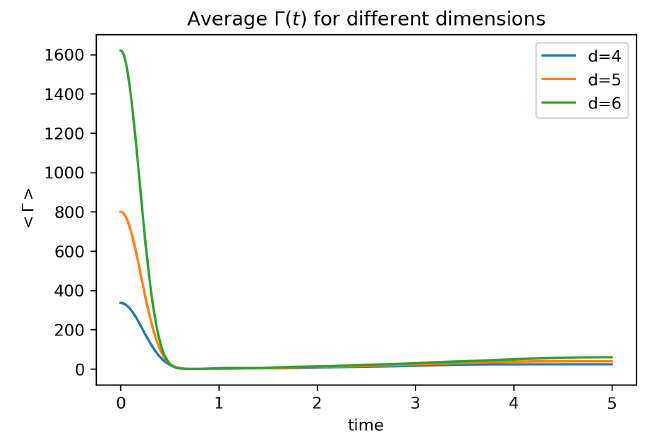
Figure 5: 〈 ξ ( t ) 〉 for d =